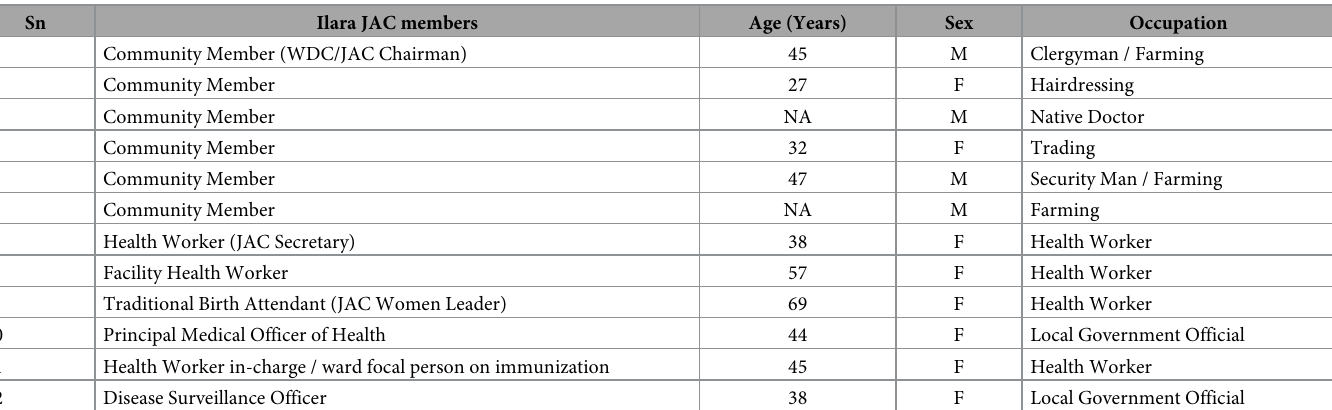
Table 2. Ilara JAC